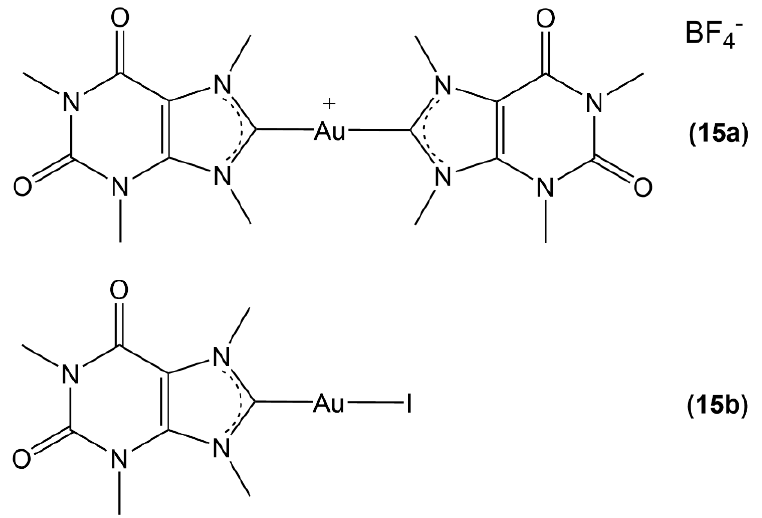
Figure 10. Gold(I) complexes with two ( 15a ) and one ( 15b ) methylcaffeine-ylidene Figure 10 . Gold(I) complexes with two ( 15a ) and one ( 15b ) methylcaffeine-ylidene group.